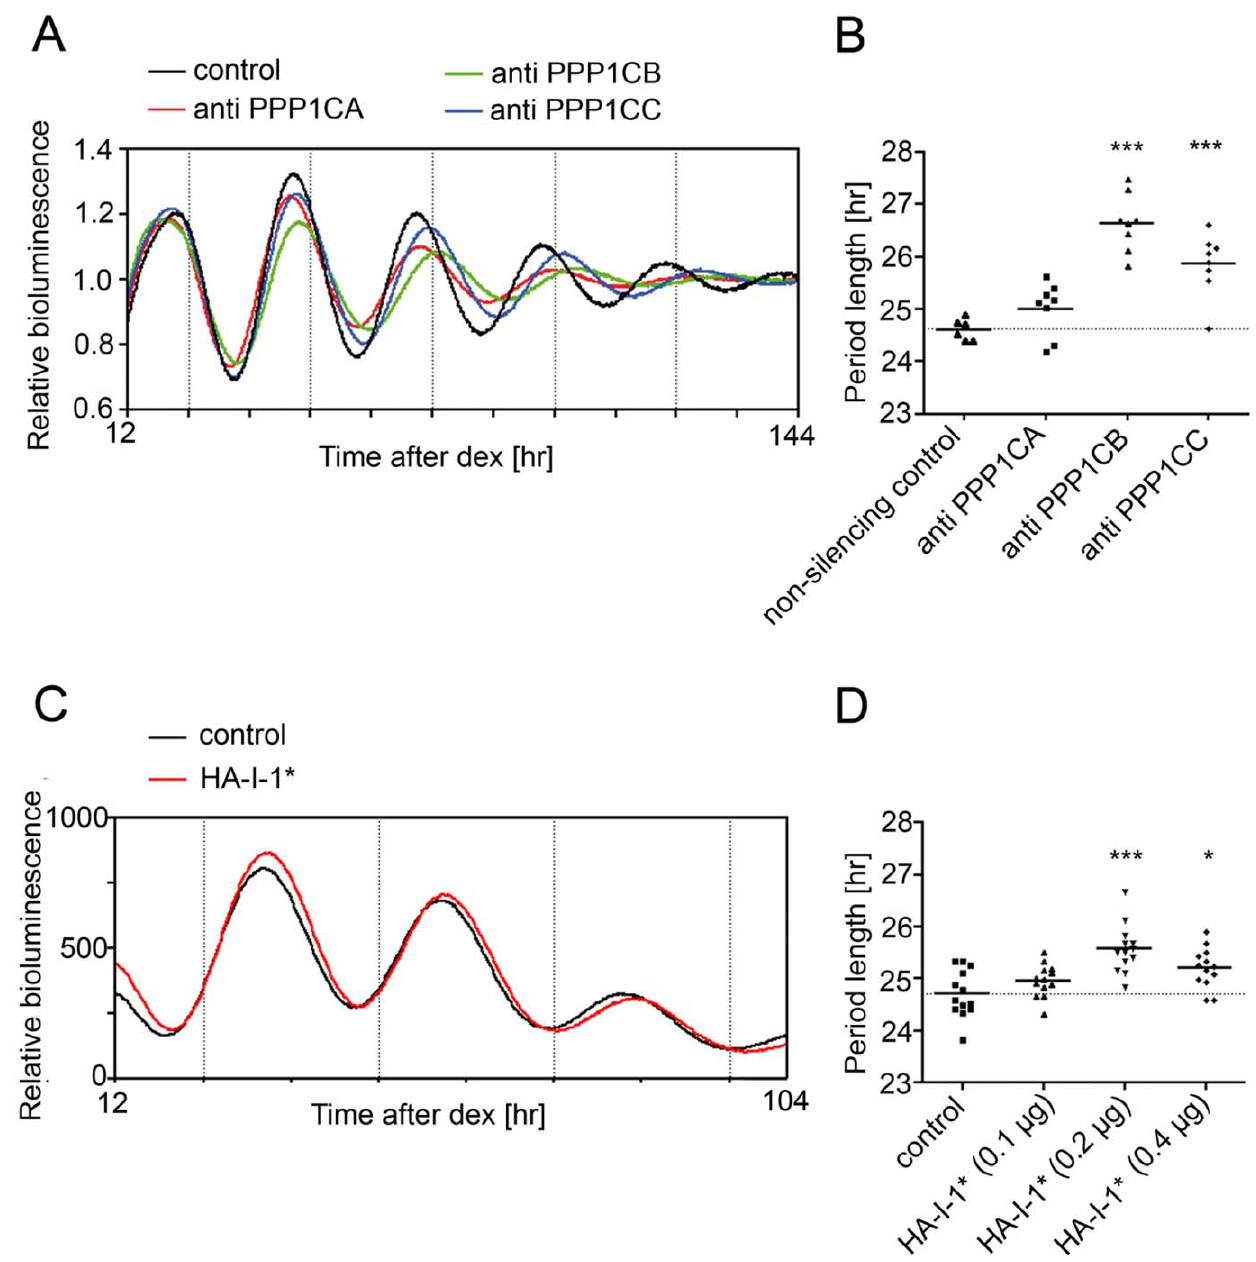
Figure 1. Reduction of PP1 activity increases period length invitro . (A) Representative real-time bioluminescence records of U-2 OS cells harboring a Bmal1 luciferase reporter vector that were lentivirally transduced with a construct containing scrambled RNAi (non-silencing control) or RNAi constructs against the catalytic subunits of PP1 (PPP1CA, PPP1CB, and PPP1CC; representative experiment out of three independent experiments; mean of three cultures). (B) Average period length of Bmal1 luc oscillations in U-2 OS cells lentivirally transduced with RNAi constructs against the catalytic subunits of PP1. Period length was determined in three independent experiments (with n=2–3 cultures). (C) NIH 3T3 cells were transfected with a Bmal1 luciferase reporter vector together with either the empty expression vector or an expression vector for I-1* (0.2 m g). Cells were synchronized with dexamethasone, and luciferase activity was measured in real-time using a LumiCycle apparatus. Luciferase counts are plotted as mean of 3 cultures (representative experiment out of four independent experiments). (D) Average period length of Bmal1 oscillations of transfected NIH 3T3 cells. Cells were transfected with 1.5 m g luciferase reporter vector, 0.1 m g pCMV-SEAP and 0.1 m g, 0.2 m g or 0.4 m g of empty expression vector/HA-I-1* expression vector (n=13 individual cultures). *** p , 0.001, * p , 0.05 indicating significance (1-way Anova). doi:10.1371/journal.pone.0021325.g001 protocol [42] under induced (on dox) and uninduced conditions the oscillator, and light pulses at CT14 and CT22, which should (off dox and on/off dox). Animals were maintained in constant provoke a phase delay and phase advance of the oscillator, darkness and 15-min light pulses of 400 lx were administered. The respectively. Both, control and I-1* mutant mice, did not phase light pulses corresponded to a pulse at circadian time (CT) 10 shift their locomotor behavior in response to light presented at which is during the subjective day and should not have an effect on CT10 under uninduced or induced conditions (Figure 3A).